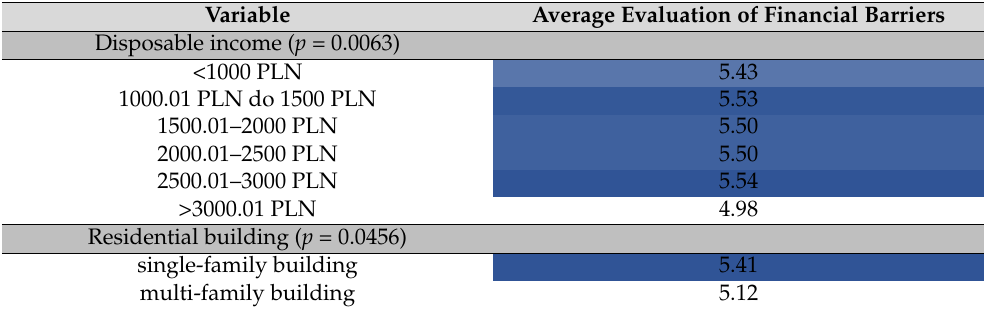
Table 12. Average ratings of energy transition barriers according to important characteristics of surveyed